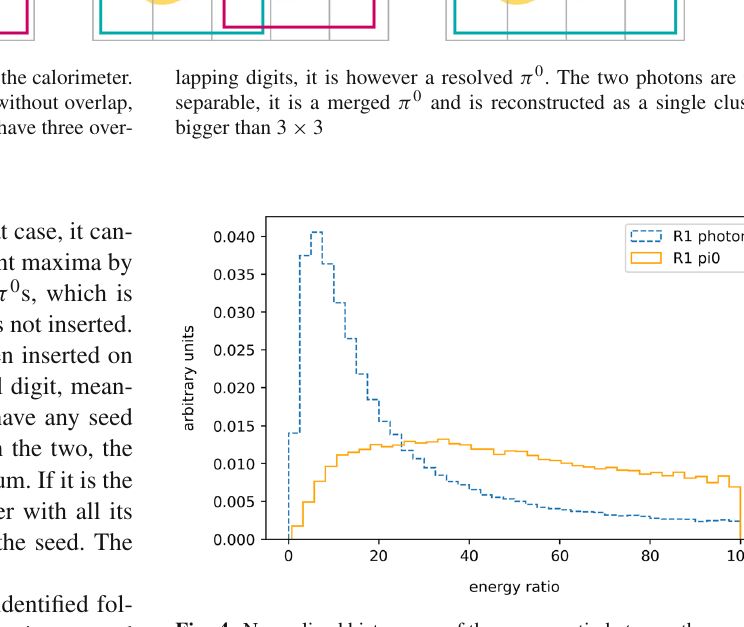
Fig. 4 Normalized histograms of the energy ratio between the second most energetic digit and the cluster seed for photon samples and π 0